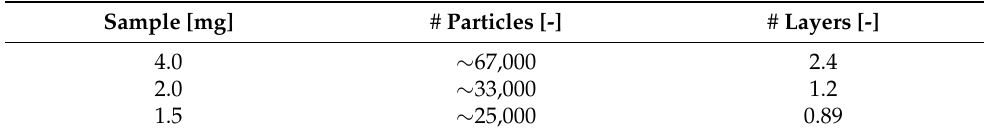
Table 1. Estimated number of particles and particle layers in the crucible.